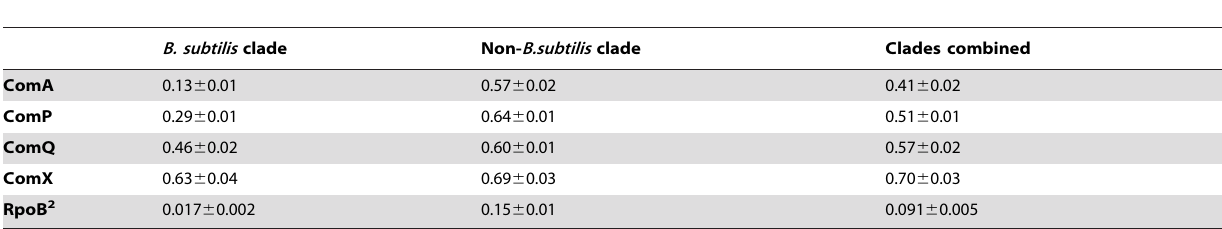
Table 1. Sequence diversity 1 of ComQXPA